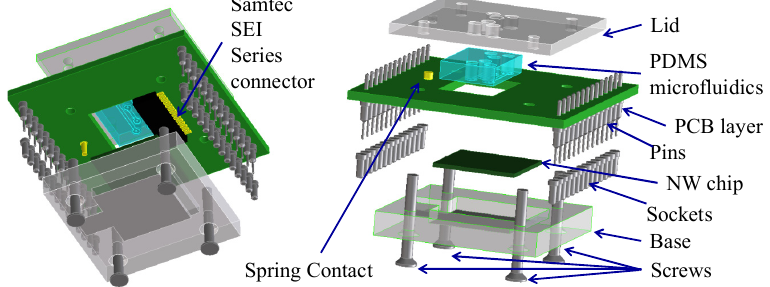
Figure 8. Drawings of the nanowire chip holder highlighting the different components stacked in a “sandwich approach”.